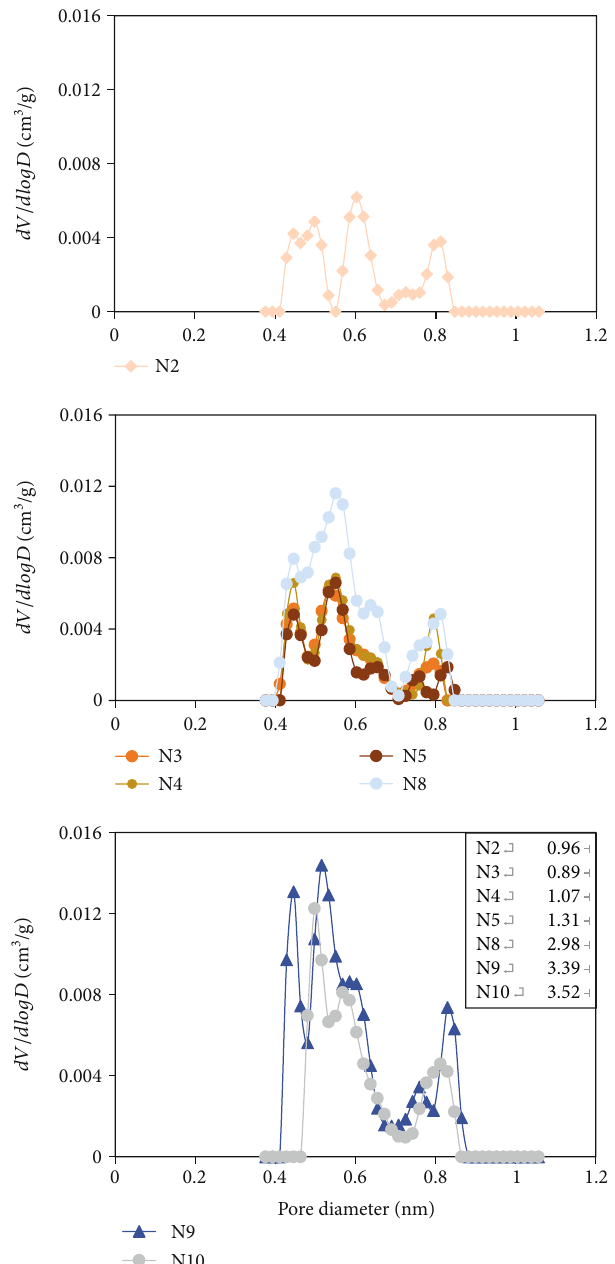
Figure 14: Log di ff erential pore volume derived from low-pressure CO adsorption for Wufeng-Longmaxi shales with samples of di ff erent 2 total organic carbon (TOC) contents. The TOC content (wt. %) of each sample is marked in the rectangle in the third panel. The micropore size distribution up to 1.2nm was calculated with the DFT model. Pores with diameter < 1 nm have di ff erent log di ff erential pore volumes. There are three higher dV / d log D peaks at approximately 0.40-0.50nm, 0.55-0.60nm, and